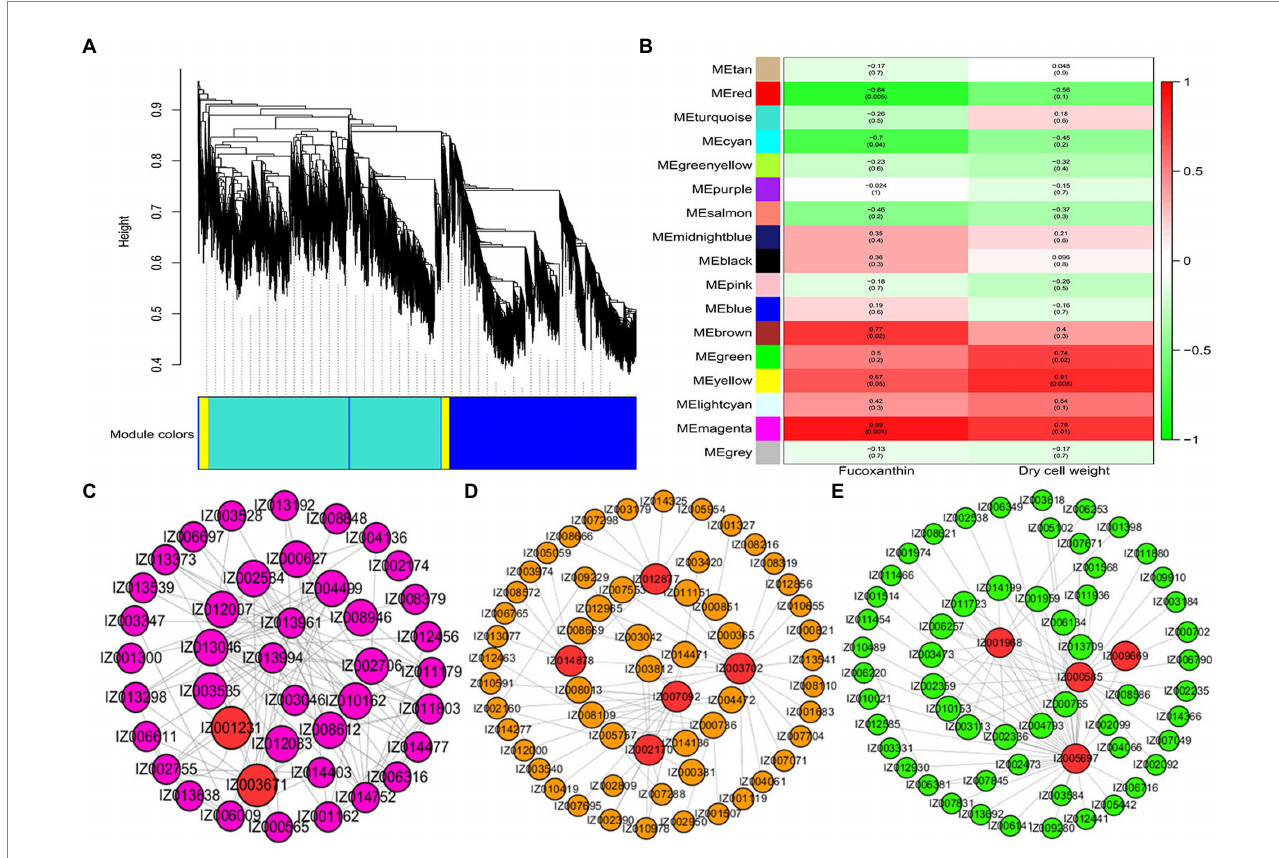
FIGURE 5 Hub genes related to the content of fucoxanthin and dry cell weight. (A) Cluster dendrogram of DEGs for WGCNA analysis. (B) Gene modules associated with the content of fucoxanthin and dry cell weight. (C) Coexpression network revealing the hub genes related to fucoxanthin and dry cell weight content in the magenta module. (D) Coexpression network revealing the hub genes related to fucoxanthin content in the yellow module. (E) Coexpression network revealing the hub genes related to fucoxanthin content in the green